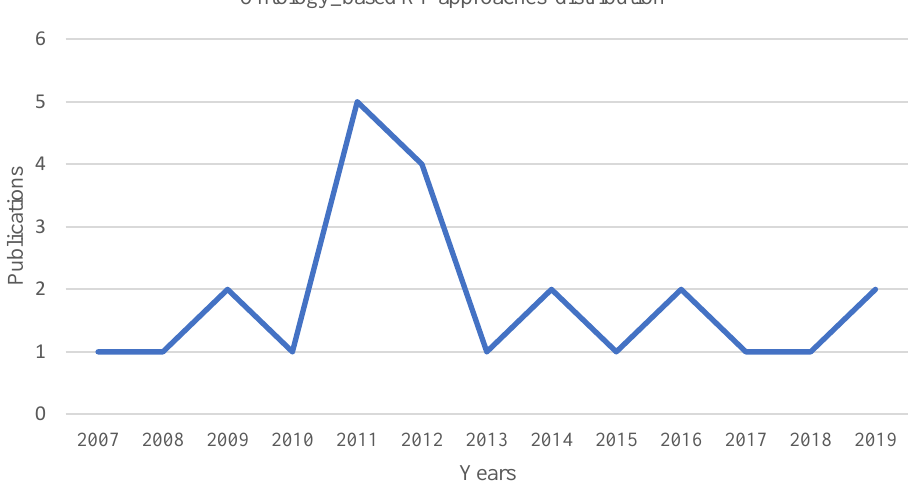
Figure 3. Year-wise publications on ontology-based regression testing.